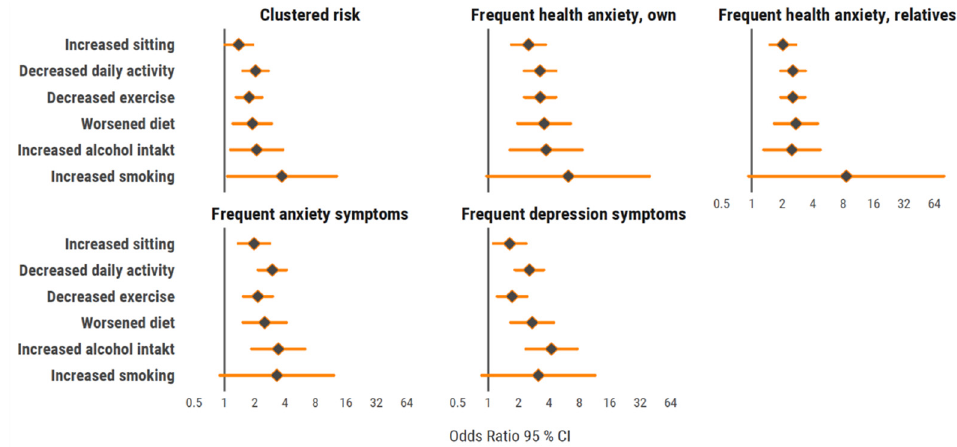
Figure 2. Forrest plot with odds ratio (95% CI) for clustering of mental ill-health variables in relation to change in lifestyle habits. All analyses adjusted for sex, age group, educational level, occupational group, wave of COVID-19, and baseline values for each lifestyle habit.